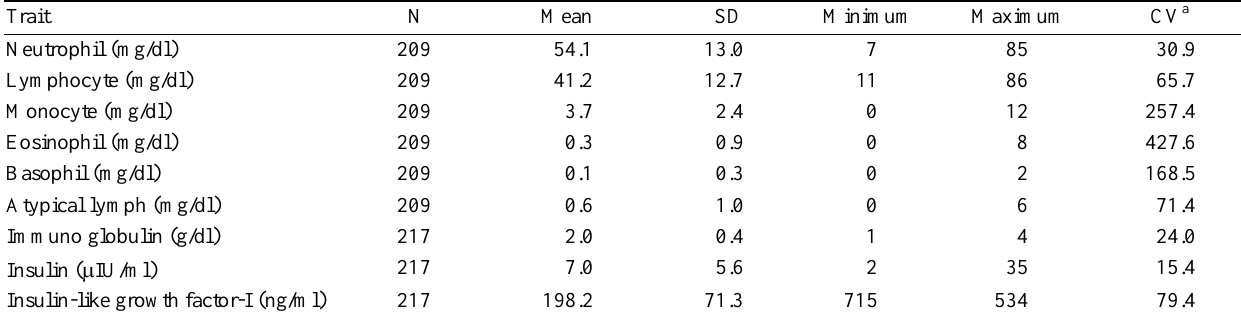
Table 1. The means and standard deviations for blood components measured in F 2 individuals from the cross between Korean native pig (KNP) and Yorkshire (YK) Trait N Mean